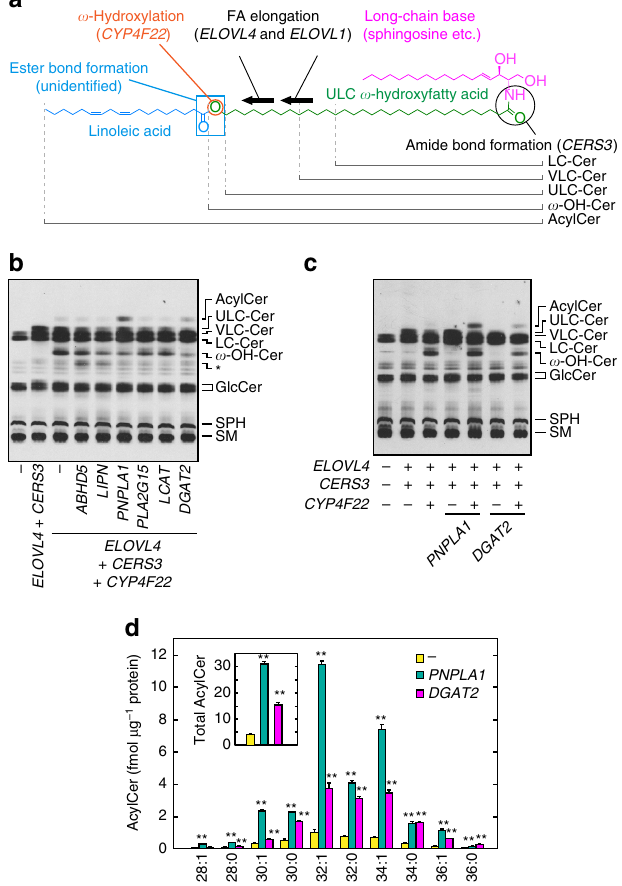
Figure 1 | PNPLA1 is involved in acylceramide synthesis. ( a ) Structure of acylceramide and genes involved in its synthesis. AcylCer, acylceramide; Cer, ceramide; o -OH-Cer, ULC o -hydroxyceramide. ( b , c ) HEK 293T cells were transfected with the plasmids encoding the indicated genes. Twenty- four hours after transfection, cells were labelled with [ 3 H]sphingosine for 6h at 37 (cid:2) C in the presence of 10 m M linoleic acid. Lipids were extracted, separated by normal-phase TLC and detected by autoradiography. GlcCer, glucosylceramide; SM, sphingomyelin; SPH, sphingosine. The asterisk indicates an undetermined lipid, the production of which was not reproducible. Five independent experiments gave similar results, and a representative result is shown. ( d ) HEK 293Tcells were transfected with an empty vector or the plasmid encoding 3xFLAG-PNPLA1 or 3xFLAG-DGAT2 , together with the plasmids encoding 3xFLAG-ELOVL4 , 3xFLAG-CERS3 and 3xFLAG-CYP4F22 . Three hours after transfection, 10 m M linoleic acid was added to the medium and incubated for 24h at 37 (cid:2) C. Lipids were extracted and subjected to LC-MS/MS analysis. Acylceramides were detected by MRM mode and quantified using MassLynx software. The graph depicts the amount of each acylceramide species with the indicated FA chain-length. The inset represents the total acylceramide levels. Values represent the means ± s.d.s of three independent experiments. Statistically significant differences compared to control cells are indicated (two-tailed Student’s t -test; ** P o